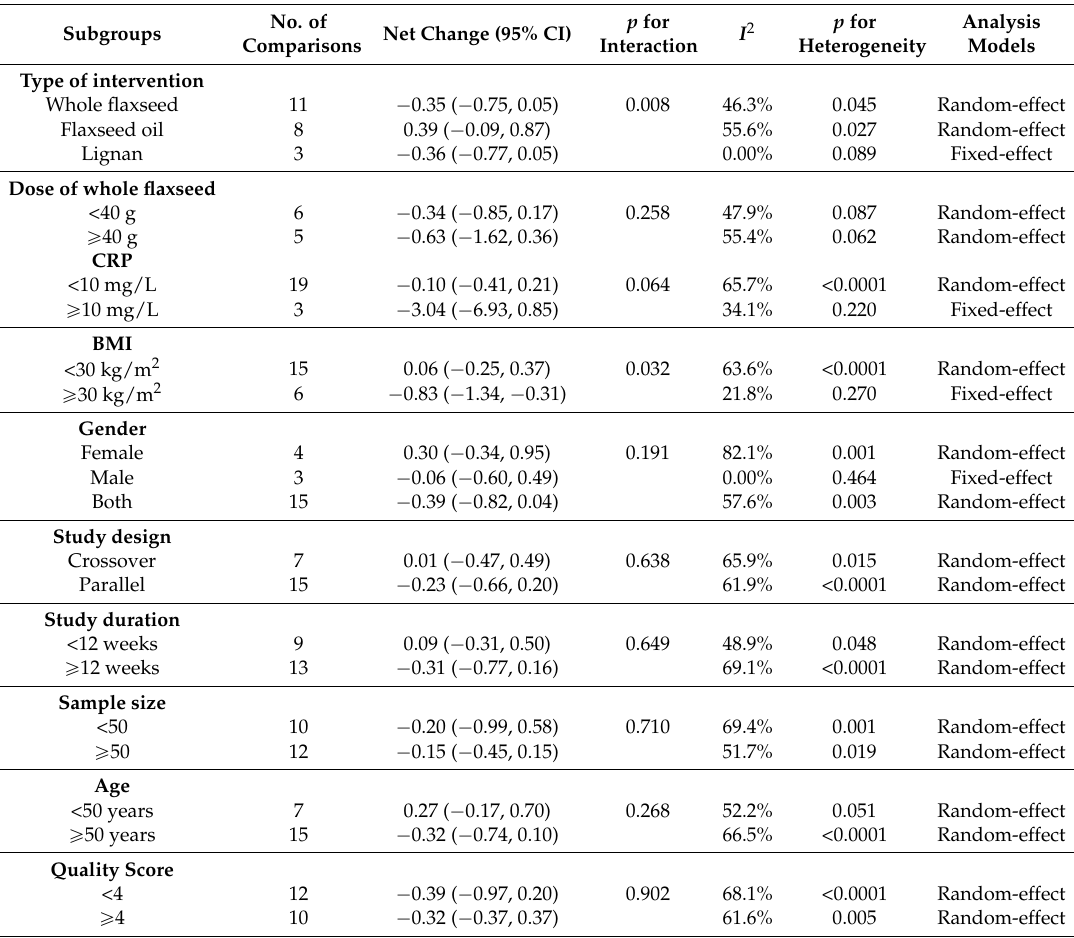
Table 2. Pooled estimates of effects on CRP within various